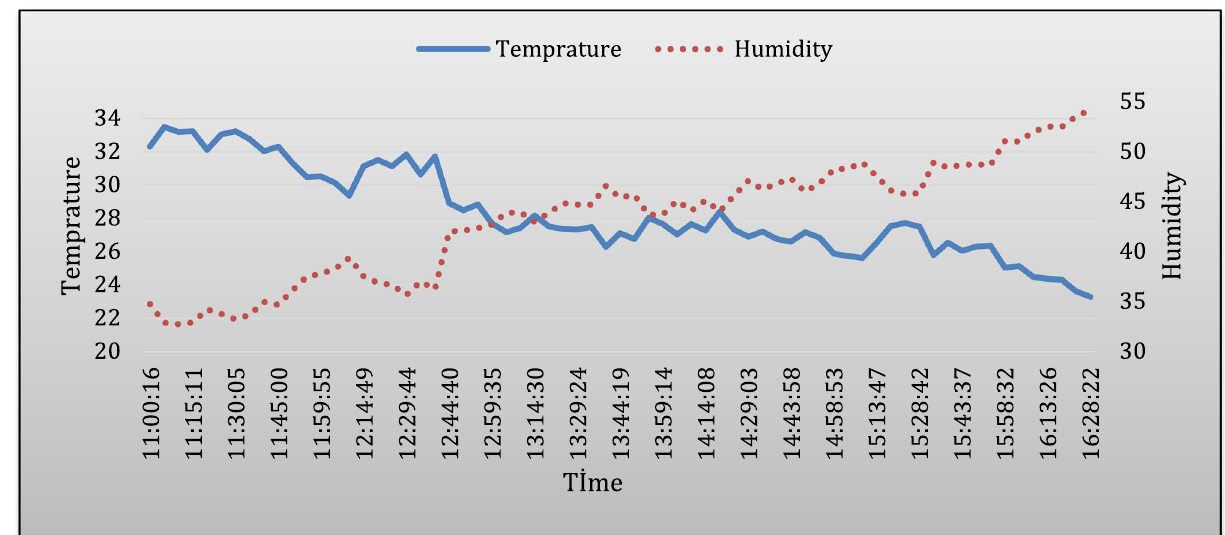
Fig. 9 Results of the experiment carried out on